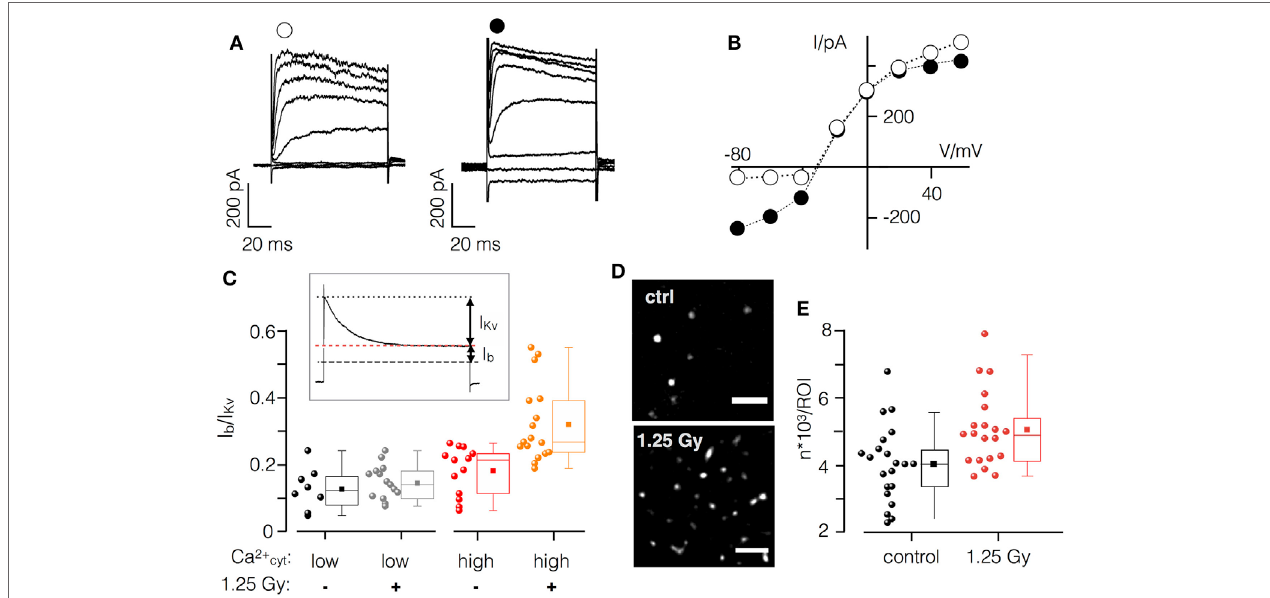
FigUre 7 | X-ray irradiation activates Ca 2 + sensitive K + channel in Jurkat cells. (a) Current responses of un-irradiated (left) and irradiate (right) Jurkat cell in whole cell configuration with high (1 µM) cytosolic Ca 2 + to test voltages between − 80 and + 60 mV. (B) Peak current/voltage relation of cells in (a) . Symbols in (a) correspond to symbols in I/V plot. (c) Inset: during long clamp steps, the time-dependent Kv1.3 current inactivates (I Kv ) leaving the voltage-independent background current I b . Ratio of I b /I Kv from non-irradiated ( − ) and irradiated ( + ) Jurkat cells (1.25 Gy) with low ( < 100 nM) or high (1 µM) [Ca 2 + ] cyt . (D) Single molecule resolution images of K Ca 2.2 channels in plasma membrane of irradiated (1.25 Gy) and non-irradiated Jurkat cells (scale bar = 1 µm). (e) Mean number of K Ca 2.2 molecules in control cells (black symbols) and 48 h after irradiation (red symbols). Each circle represents an individual region of interest (ROI) of a single Jurkat cell. Box plot symbols have the same meaning as in Figure 2